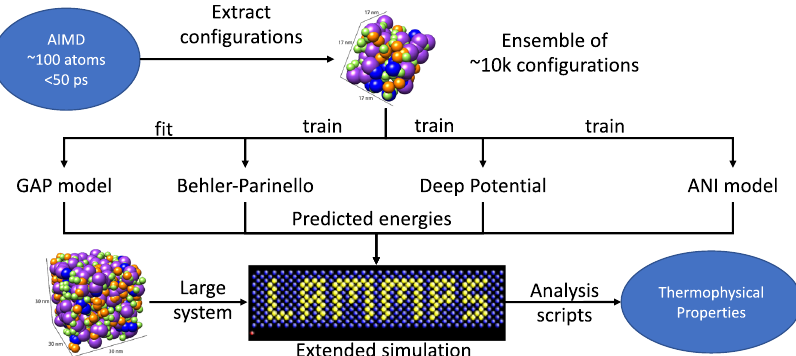
Fig. 5 Overview of typical methods used in recent machine learning based studies of molten salts. A short ab-initio molecular dynamics simulation of a small system generates a training set. One of four commonly used models is fi tted or trained. A larger system is then simulated using the custom trained potentials for extended periods. The resulting trajectories are analyzed and thermophysical properties